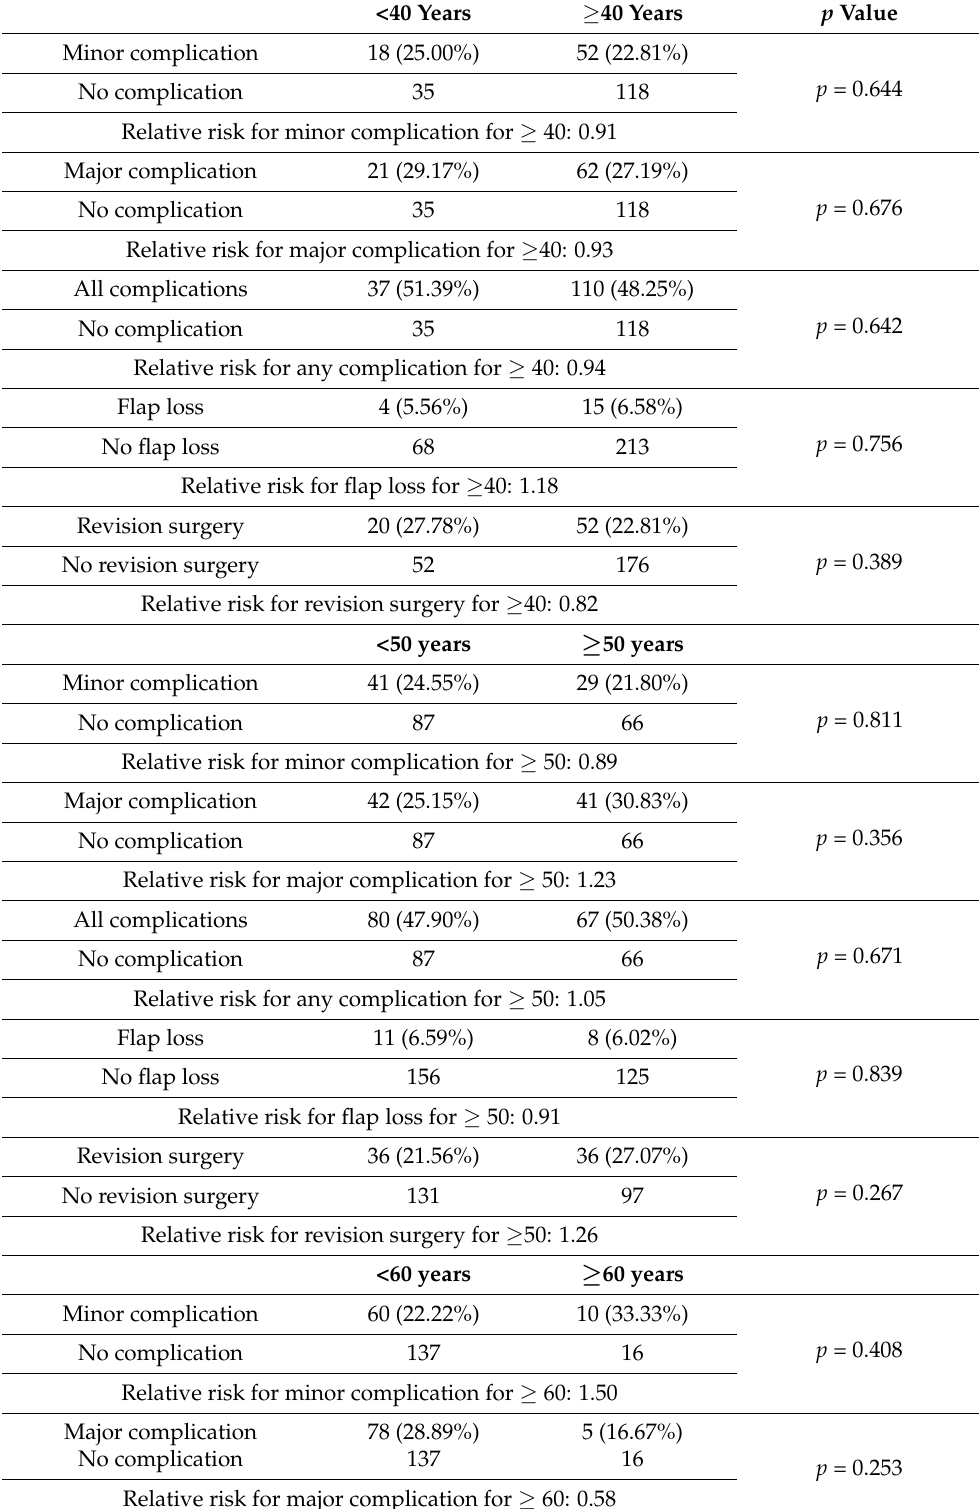
Table 3. Age groups were formed by sorting into over 40, over 50 and over 60 and compared to the younger patients regarding major complications, minor complications, overall complications, flap loss and revision